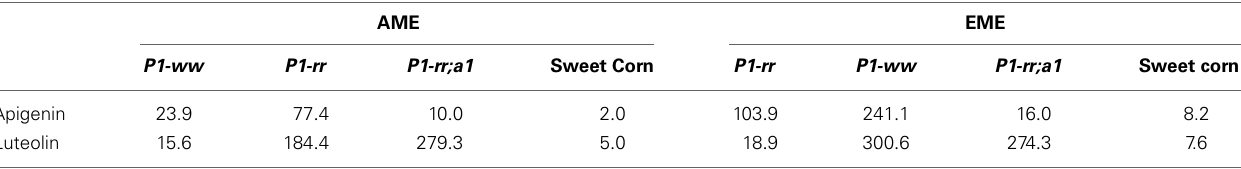
Table 3 | Apigenin and luteolin contents in whole-food maize